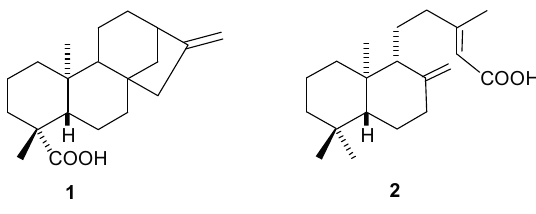
Figure 1. Biologically active diterpenes 1 and 2